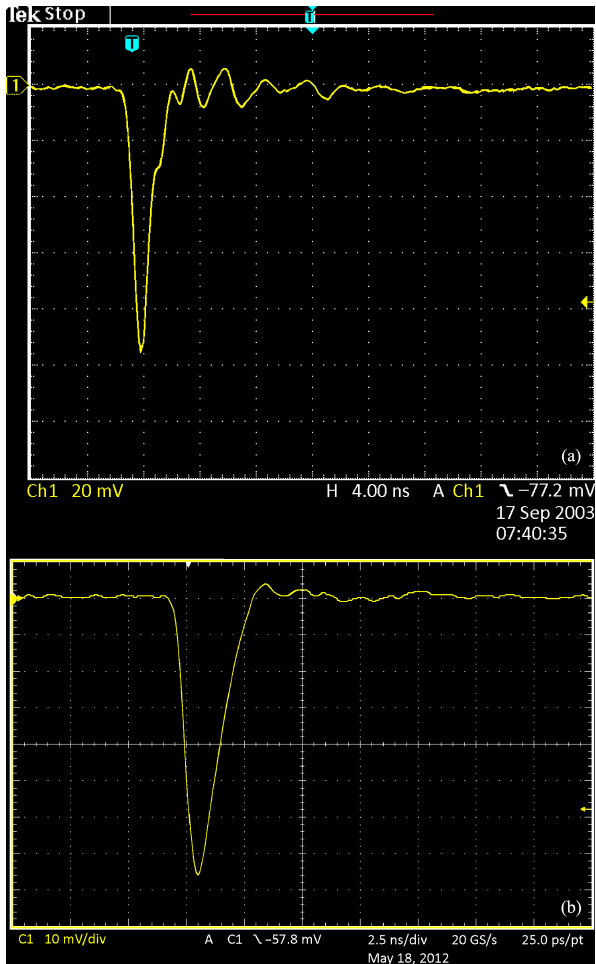
Figure 9. (a) Single-photon pulse from a Hamamatsu 5600 or 7400 PMT, measured with a 500MHz digital oscilloscope (Tek- tronix, TDS 3045 C). (b) Single-photon pulse from a Hamamatsu R7400P-03 PMT with the most recent version of the Romanski (RSV) socket, measured with a 1GHz digital oscilloscope (Tek- tronix, DPO 7104).